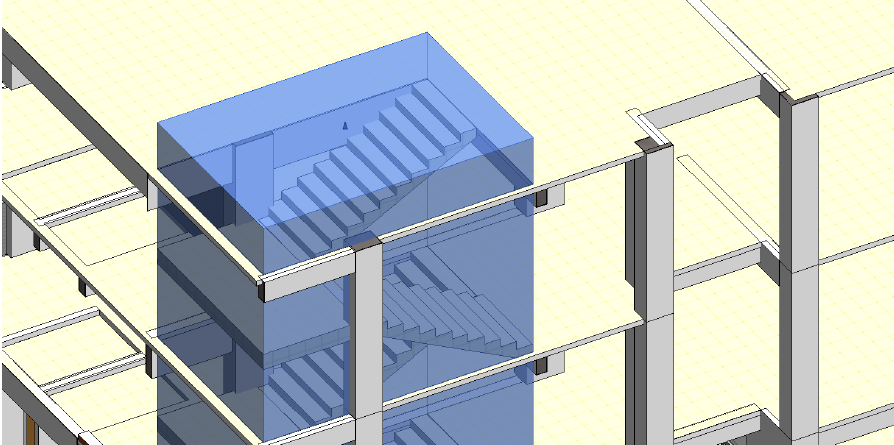
Figure 18. Top floor stair opening.